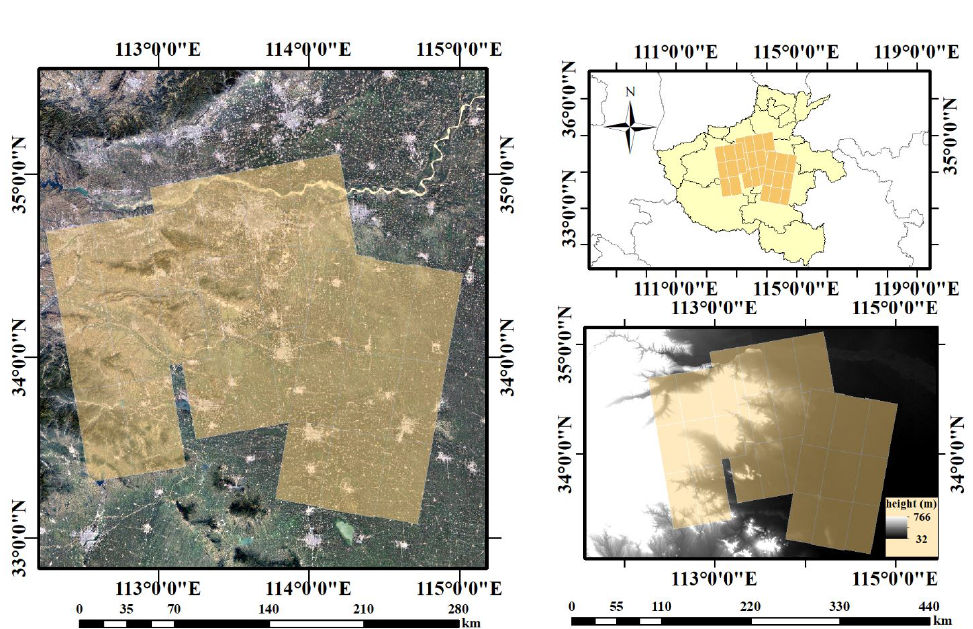
Figure 6. Experimental data and area, including the terrain of the experimental area and the location of CoSSC data. The left picture is the optical map of the experimental area, the upper right image is the administrative division map, and the lower right image is the external